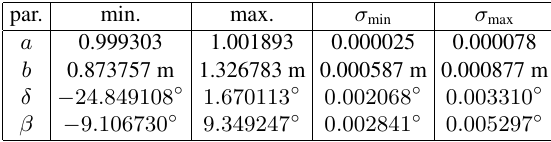
Table 2: Shows the estimation results comprising the results for the 64 lasers. For all estimated parameters, the range, the minimal and maximal estimated standard deviations are listed.